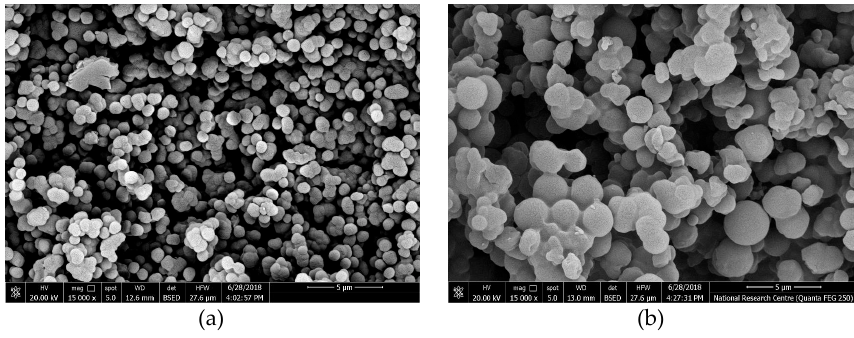
Figure 2. SEM images of ( a ) MIP and ( b ) NIP nanobeads.